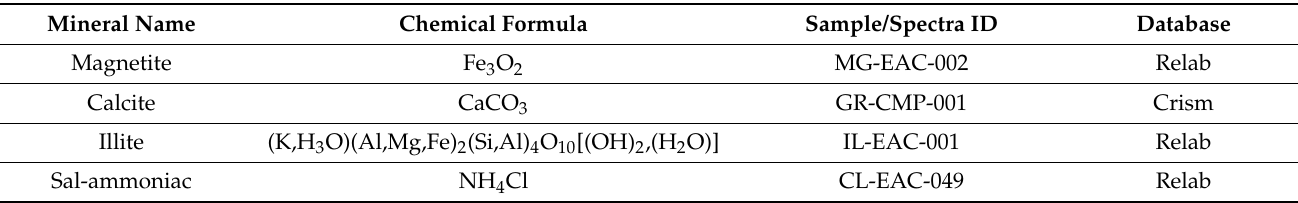
Table A1. Minerals used in evaluating mixing model results in addition to the samples analyzed within this work. Samples are taken from Relab Brown University (http://www.planetary.brown.edu/relab/ (accessed on 23 June 2021)) and the CRISM spectral library (https://speclib.rsl.wustl.edu/ (accessed on 4 June